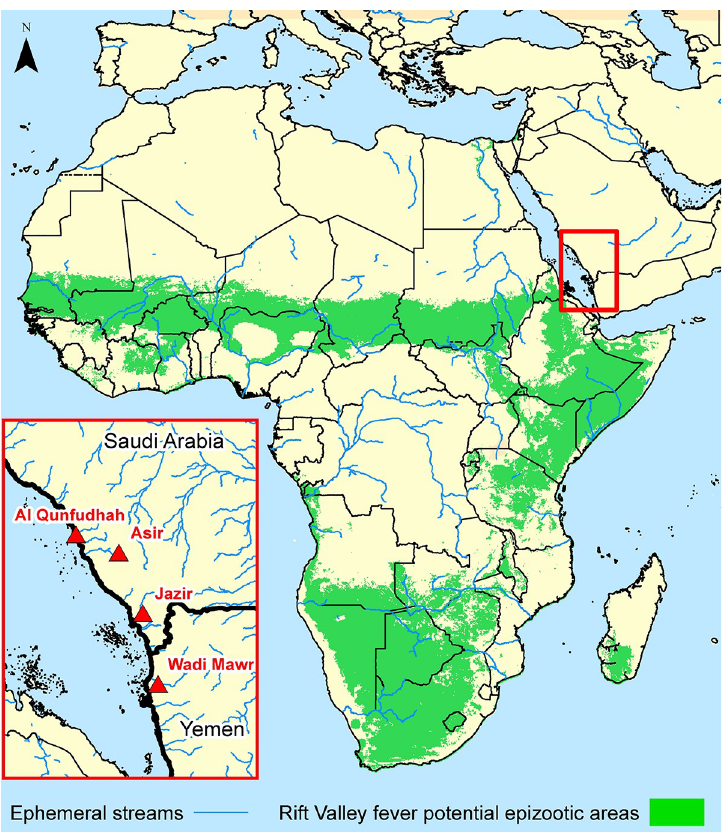
Fig 1. Potential epizootic areas of Rift Valley fever in Africa and Madagascar are shown in green [4]. Four areas in Saudi Arabia and Yemen are shown in the insert where significant numbers of people were infected in the 2000–2001 outbreak were noted by the red triangles. While Rift Valley fever has largely been an African disease, there were no documented Rift Valley fever outbreaks in Arabia prior to 2000–2001 and there have been none since that time.